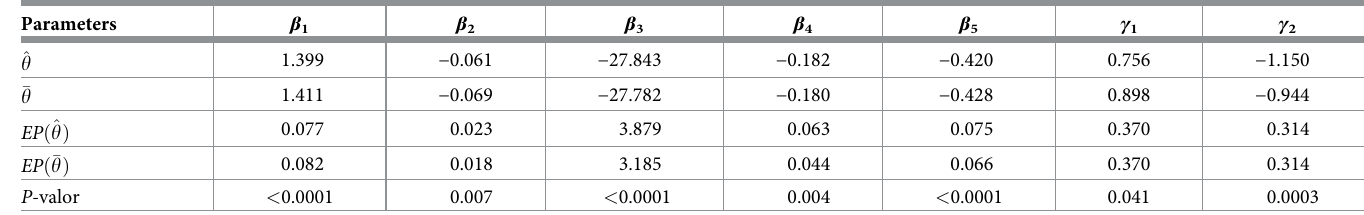
Table 10. Maximum likelihood estimates ð ^ θ Þ , bootstrap bias-corrected estimates ( � θ ), standard errors (SE) and p -values associated with Z -tests for the parameters of the [13]. Fluid Catalytic Cracking Data (FCC). Parameters